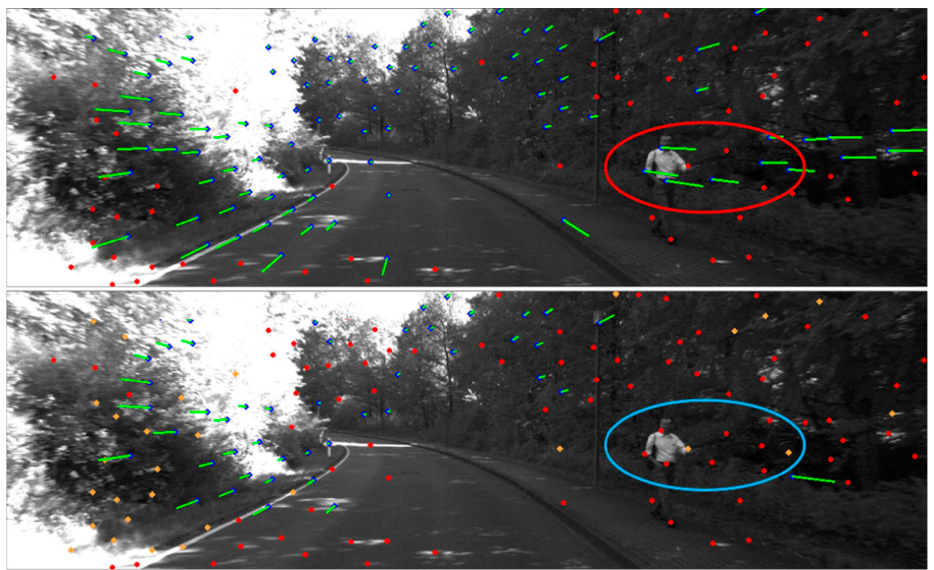
Figure 10. Top: before optimization (top image). Bottom: after optimization (sequence 09; frame 60).